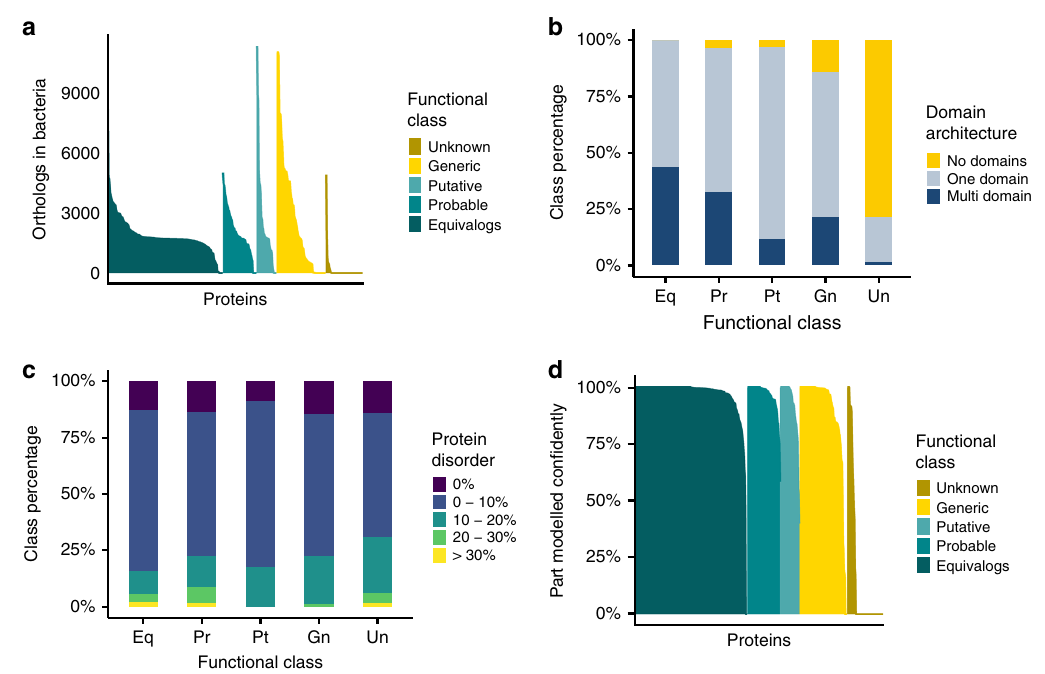
Fig. 1 Basic characterisation of proteins encoded by the minimal bacterial genome. a Orthologues identi fi ed in bacteria. Results for each functional class are represented by a different colour: gold for the Unknown class, yellow – Generic, light turquoise – Putative, turquoise – Probable and dark turquoise – Equivalog. b The domain architecture for proteins in each of the fi ve functional con fi dence classes is plotted (Unknown [Un], Generic [Gn], Putative [Pt], Probable [Pr] and Equivalog [Eq]). Proteins with no domains are displayed in yellow, grey represents single domain proteins and dark blue multi-domain proteins. c Predicted protein disorder in the minimal genome proteins. The results are shown for the fi ve con fi dence classes from b and coloured according to the percentage of disorder present. Proteins with a percentage disorder >30% are represented by yellow, 20 – 30% disorder by green, 10 – 20%-turquoise and 0 – 10%-blue. Purple indicates proteins without disordered regions. d The percentage of protein structure that can be con fi dently modi fi ed by Phyre2. Functional class colouring as for a